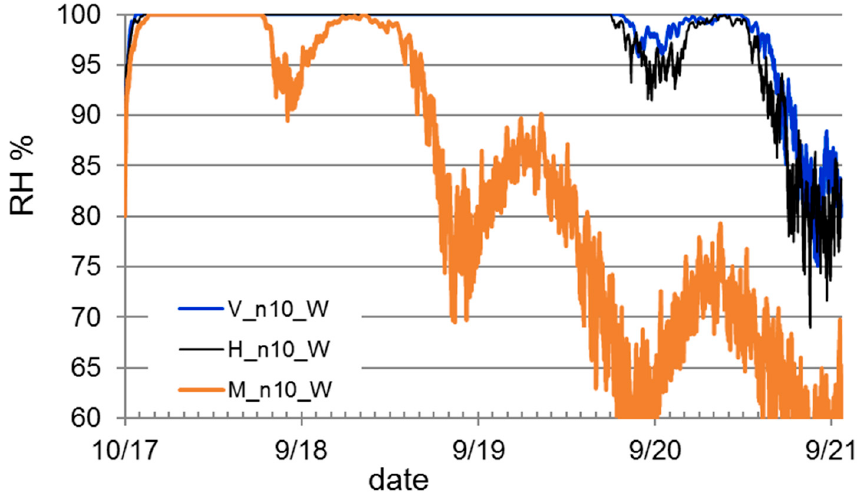
Figure 13. Brick wall, ventilation scheme 1, n = 10 1/h, initially wet exterior core of the old brick wall. The relative humidity in the ventilation air space in three different climates during the four-year simulation period.